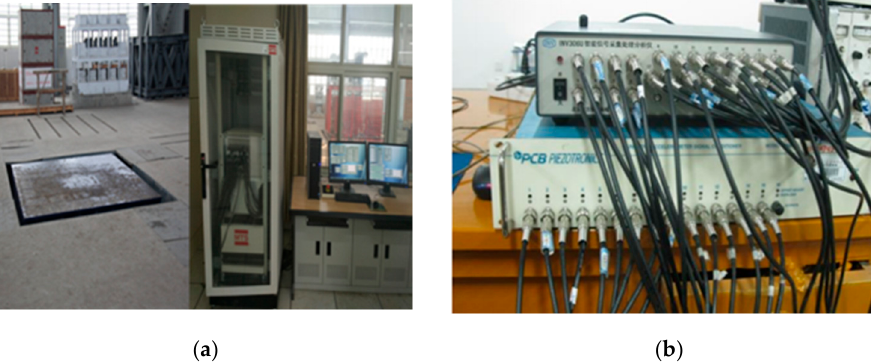
Figure 5. Testing equipment. ( a ) Field of shaking table and control system; ( b ) LMS data acquisition instrument (under test).